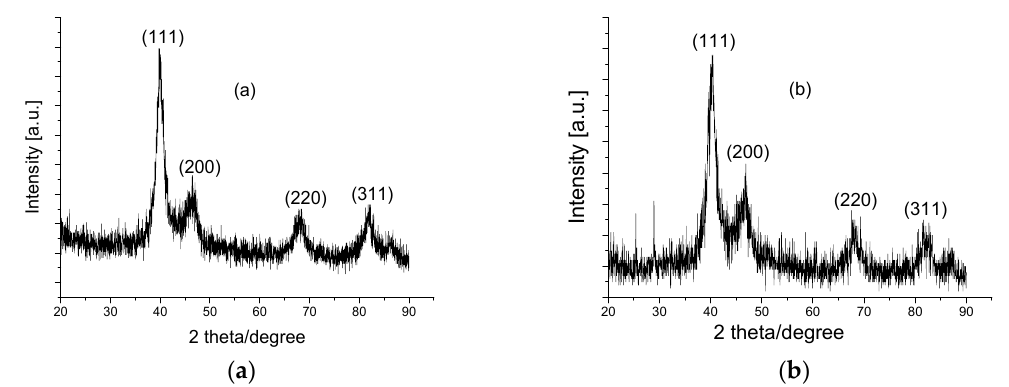
Figure 5. XRD patterns of C2 ( a ), and C2 recovered after the Suzuki–Miyaura reaction ( b ).